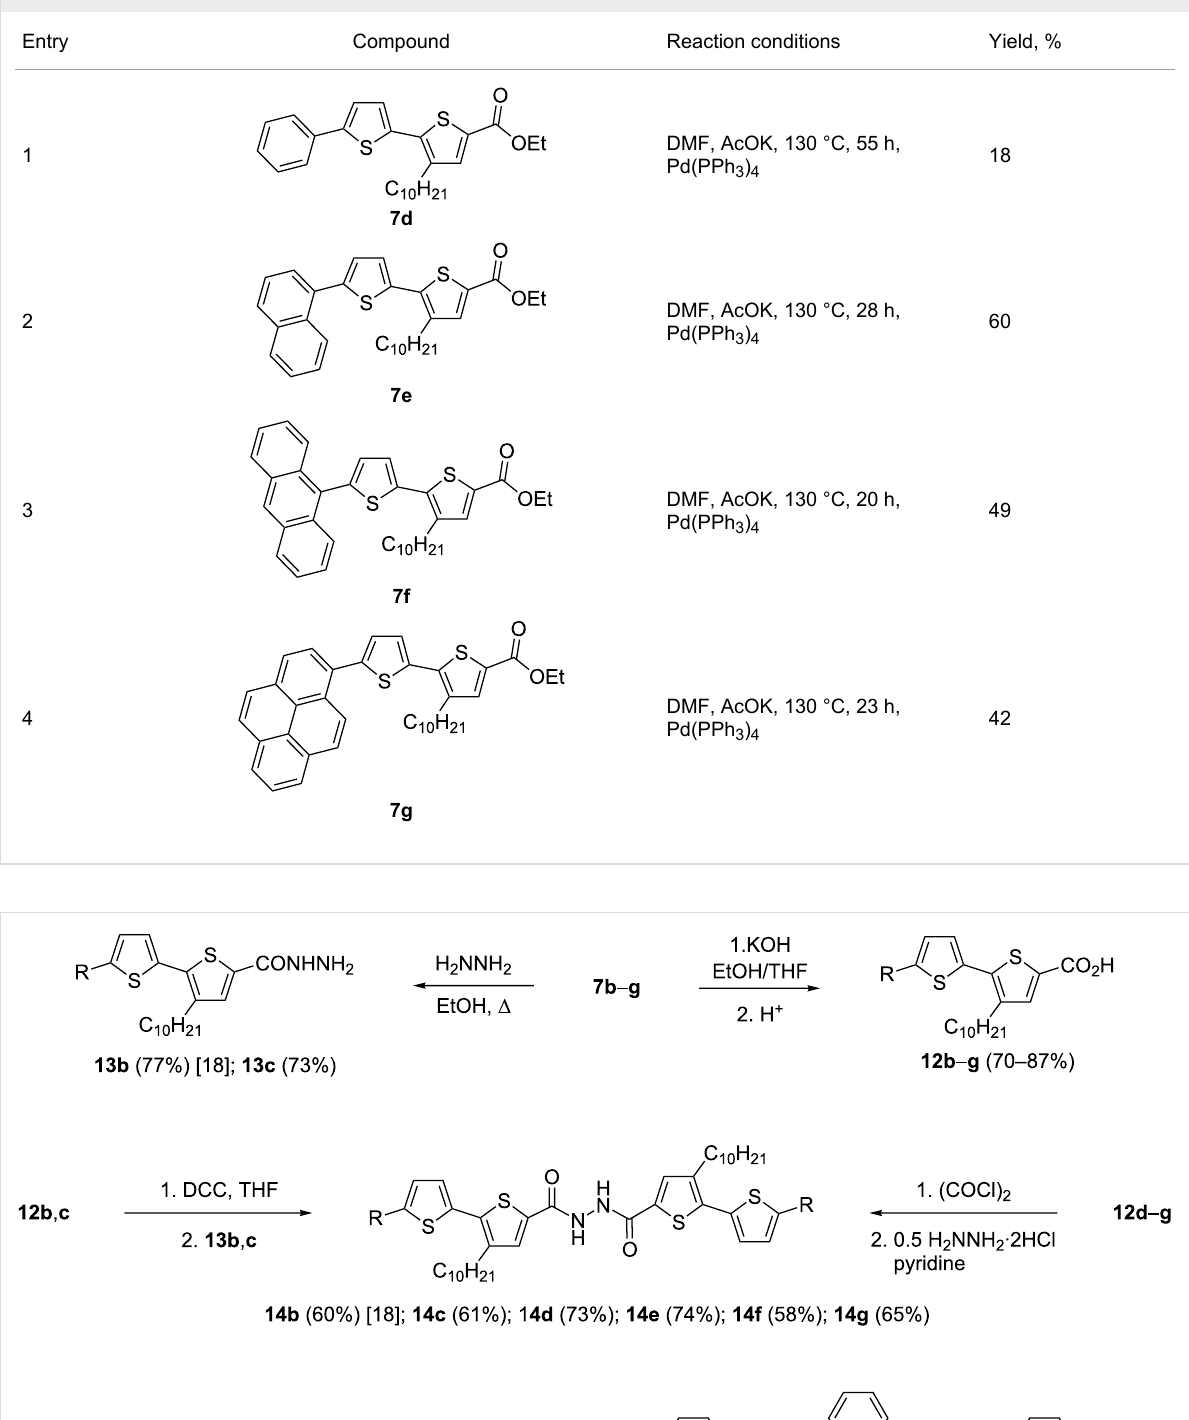
Table 1: Reaction conditions and yields for the synthesis of ethyl 5'-aryl-3-decyl-2,2'-bithiophene-5-carboxylates 7d – g . Entry